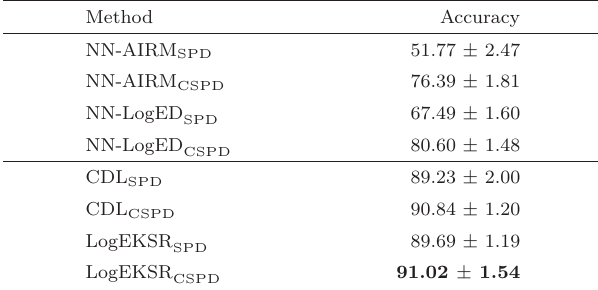
Table 2 Recognition rates with standard deviations, hand gesture